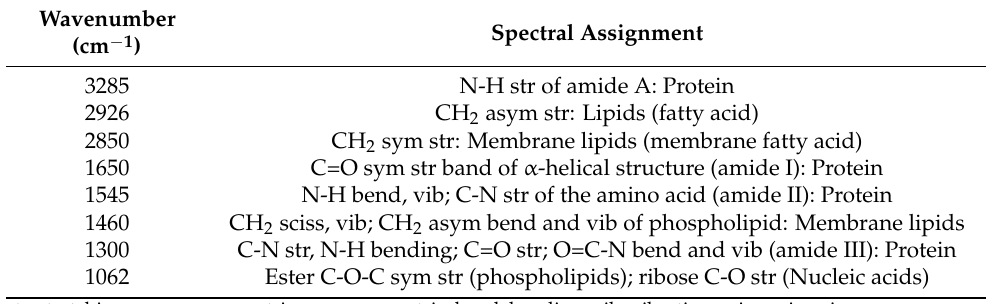
Figure 9. Representative FTIR spectra of the sciatic nerve of the normal, VCR, and withametelin groups ( A ). WMT significantly inhibited VCR-induced changes in the biochemical composition of the myelin sheath. Effect of the withametelin treatment on the protein structure ( B ). DSC thermogram confirmed that the withametelin treatment markedly suppressed any VCR-induced protein structure alterations. Table 1. Spectral assignment of the band frequencies with a spectral range of 450–4000 cm −1 .